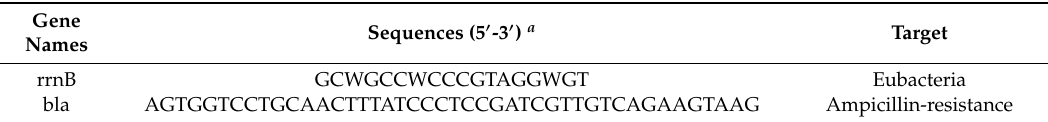
Table 1. Oligonucleotide sequences used in the experiments